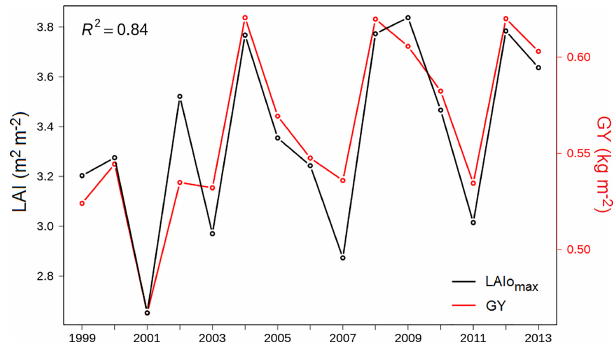
Figure 2. Interannual variability of straw cereals in France: 15-year time series (1999–2013) of the mean disaggregated satellite-derived LAIo max and of the mean Agreste grain yield (GY) observations for 31 French départements where LAIo max and GY are significantly correlated. The fraction of explained variance is R 2 =